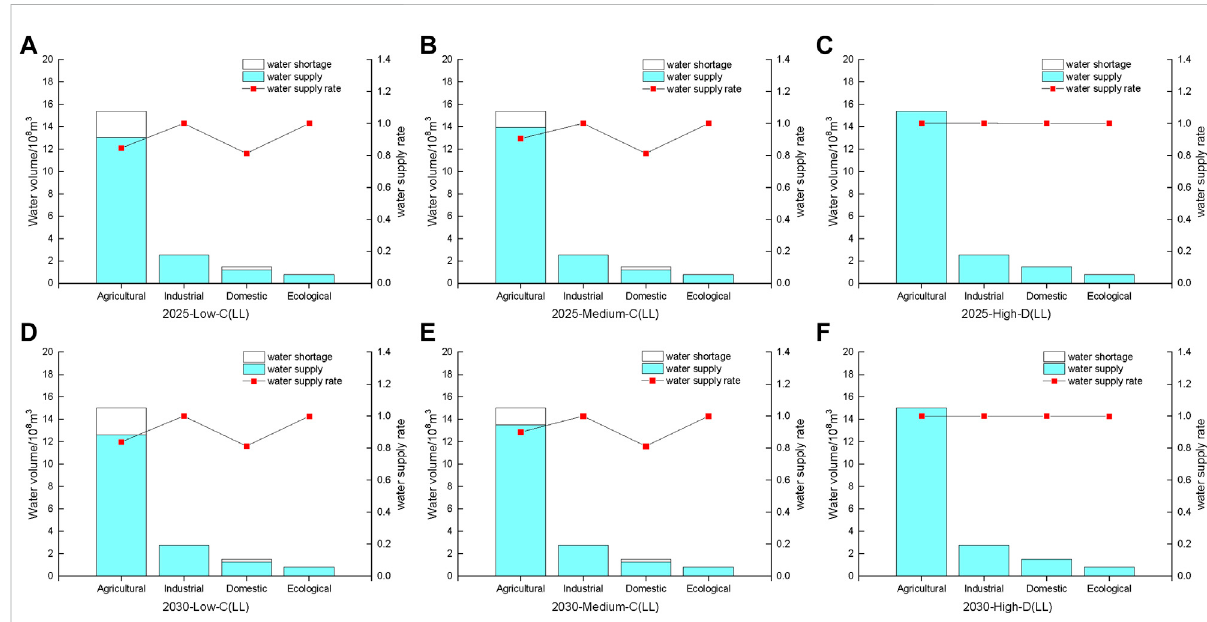
FIGURE 11 Distribution of water resources for six suitable scenarios in Luokou-Lijin section [ (A – F) represent 6 selected scenarios respectively].